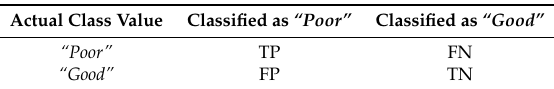
Table 3. Confusion